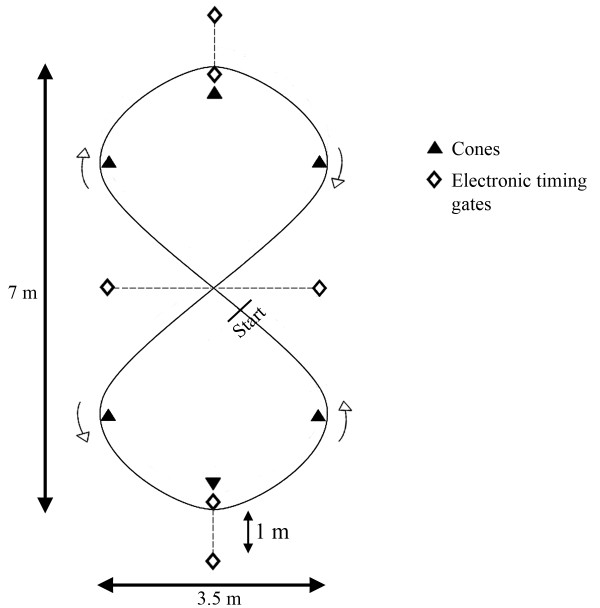
Figure-of-eight sprint track.